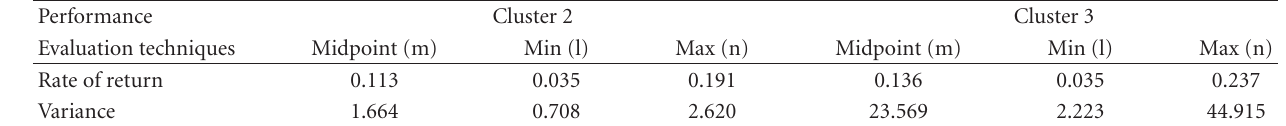
Table 2: Cluster Results Used in Fuzzy.